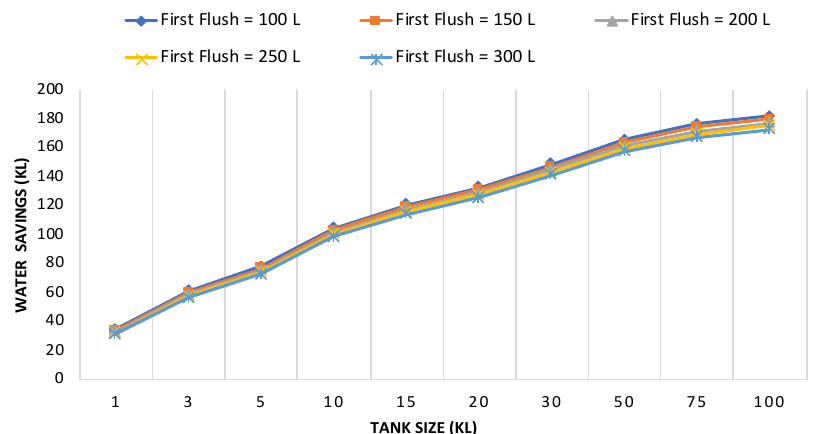
Figure 6. Water savings–first flush–tank size relationships for Sydney (combined use). Figure 7 shows variability in annual water savings across the eight different cities. Red boxplots show variability in TLD use, green shows irrigation use and blue shows combined use. A large size box represents high variability between water savings for a particular location, while a smaller box shows less variability. As shown in Figure 7, beyond the 10 m 3 tank, water saving becomes almost constant for most of the locations except Darwin and Perth.